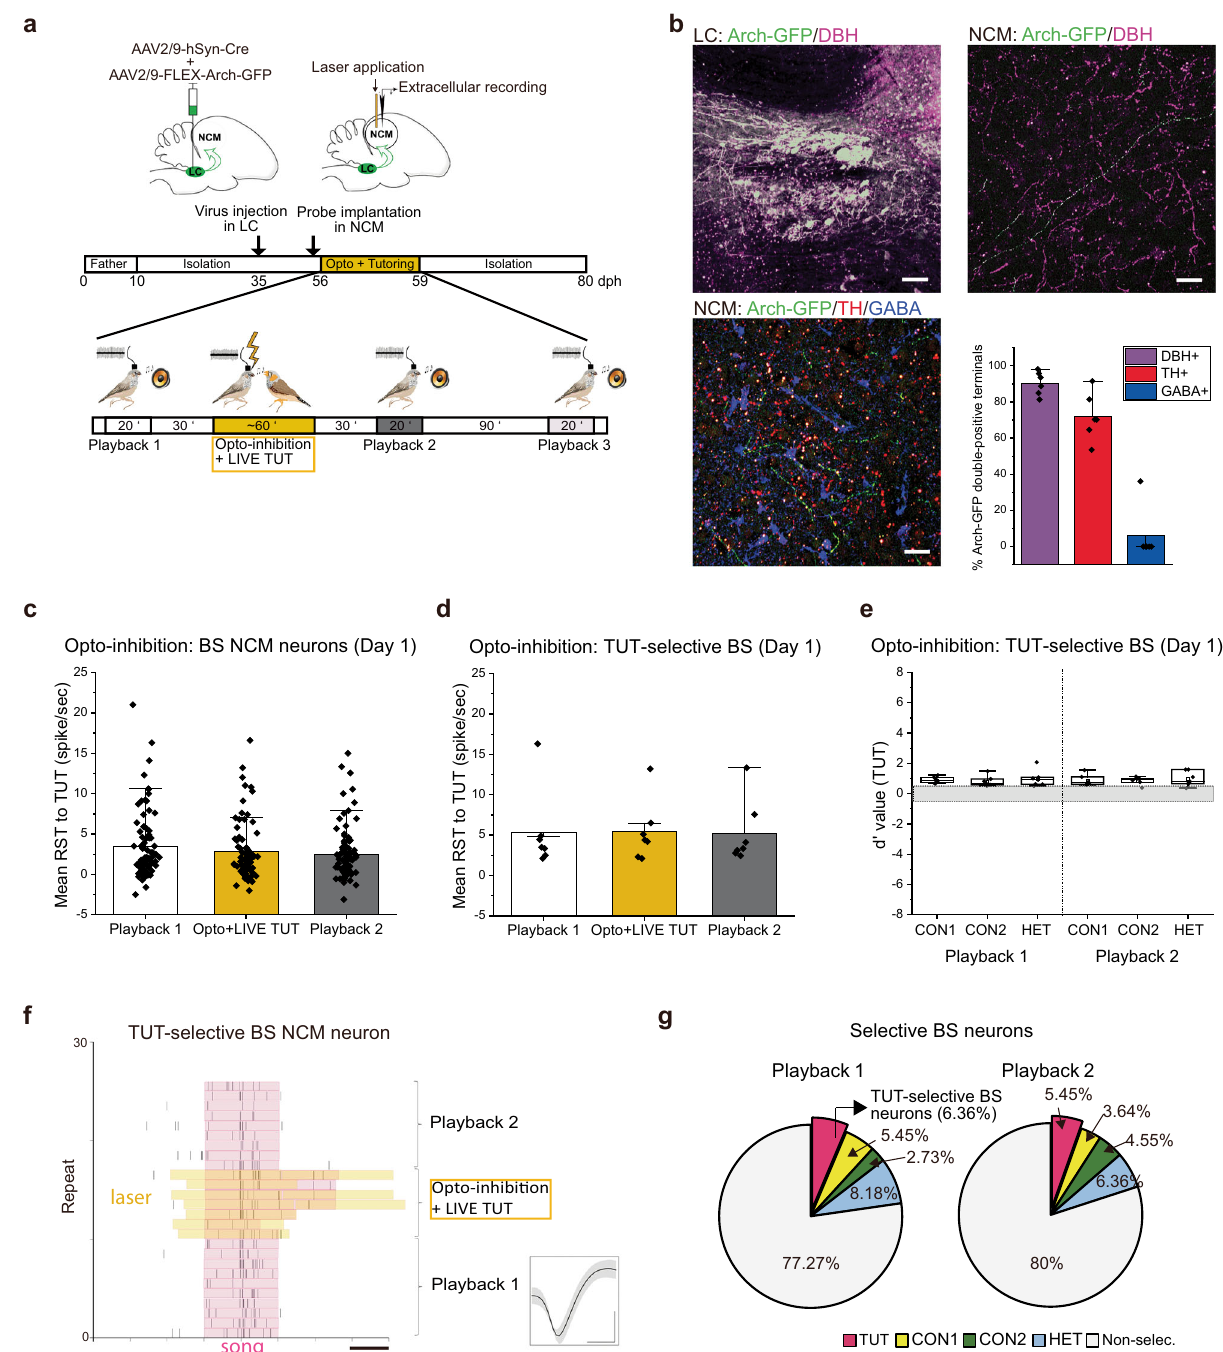
increase their RST to TUT playback after being exposed to LIVE TUT (Fig. 3c, Playback 2). A small subset of BS NCM neurons ( n =7), which exhibited selective auditory responsiveness to TUT playback before the exposure of LIVE TUT singing in the fi rst day of tutoring, did not increase their responses to LIVE TUT and selectivity to TUT when optogenetic inhibition was applied during LIVE TUT (Fig. 3d – f). Optogenetic inhibition of LC axons in the NCM did not change the spontaneous fi ring rate of those neurons (2.63 ± 0.86 vs 2.31 ±1.09, Playback 1 vs LIVE TUT+ Opto-inhibition). Moreover, the proportionof TUT selective BS neurons did not increase after being exposed to